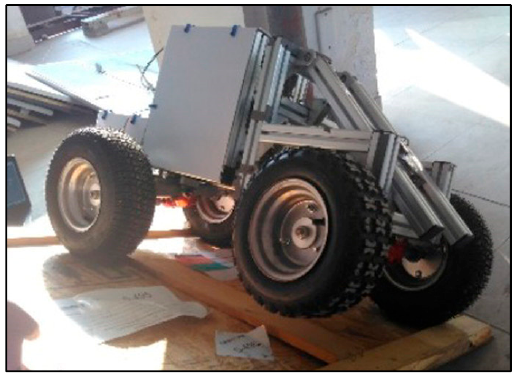
Figure 14. Static rollover stability test site.